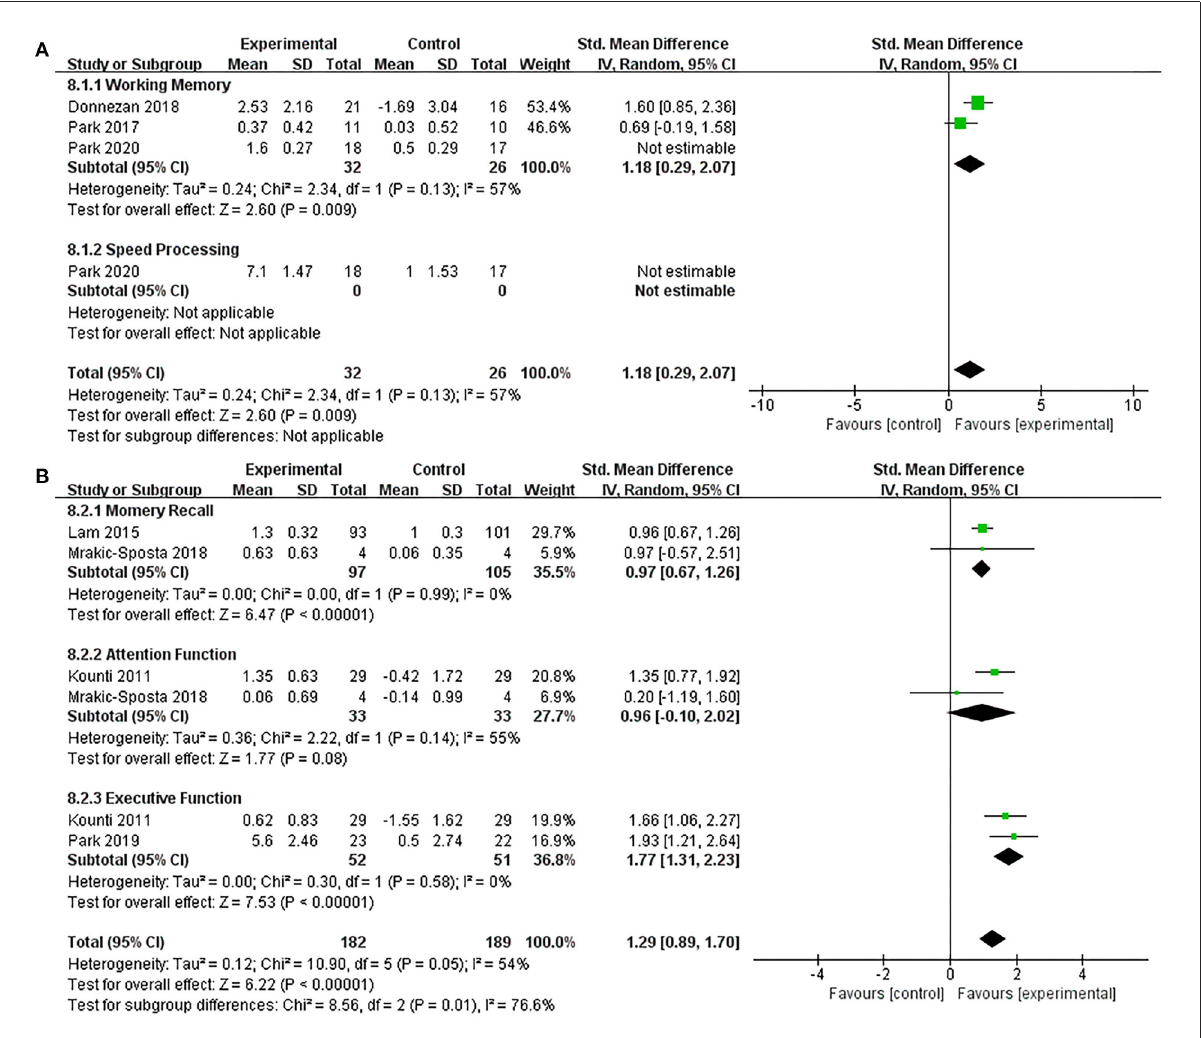
FIGURE6 Forest plot of the efficacy of the combined intervention on cognition domains in older adults with MCI. (A) Combined intervention vs. single cognitive intervention (sensitive analysis), (B) combined intervention vs. sham intervention.